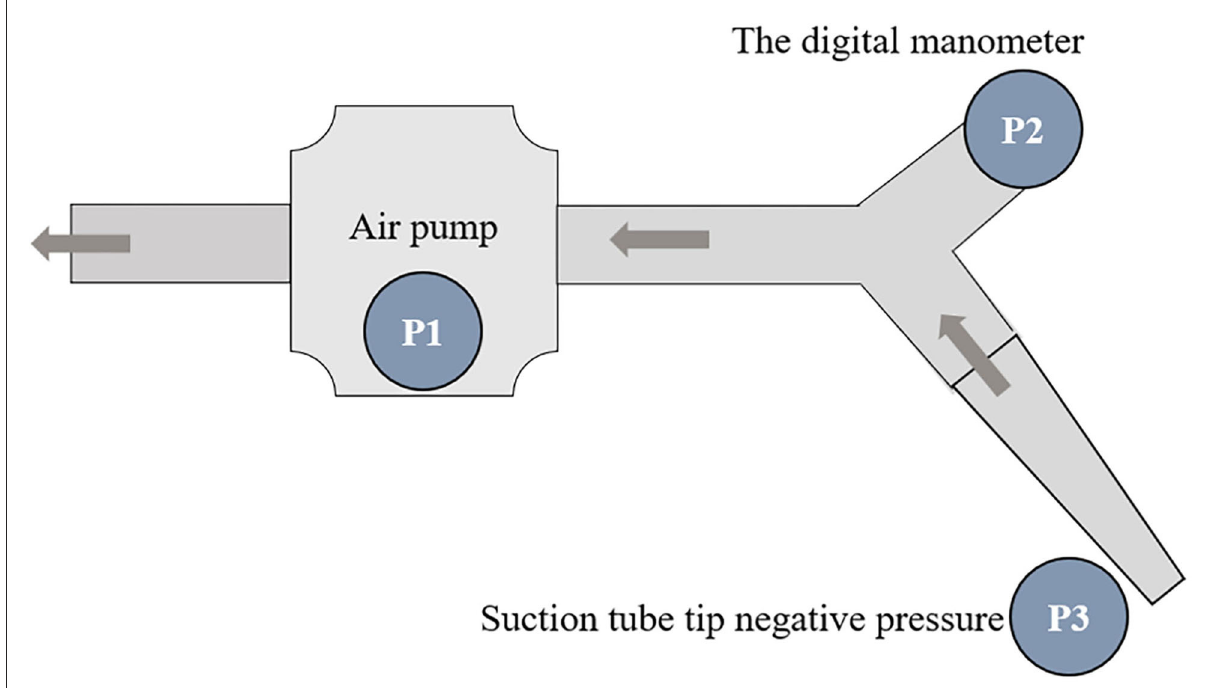
FIGURE3 The working mode diagram of an independent negative pressure system. P2 was measured by a digital manometer. P3 stood for the tip negative pressure, which was equal to P1 and P2, when the negative pressure system became vacuum.